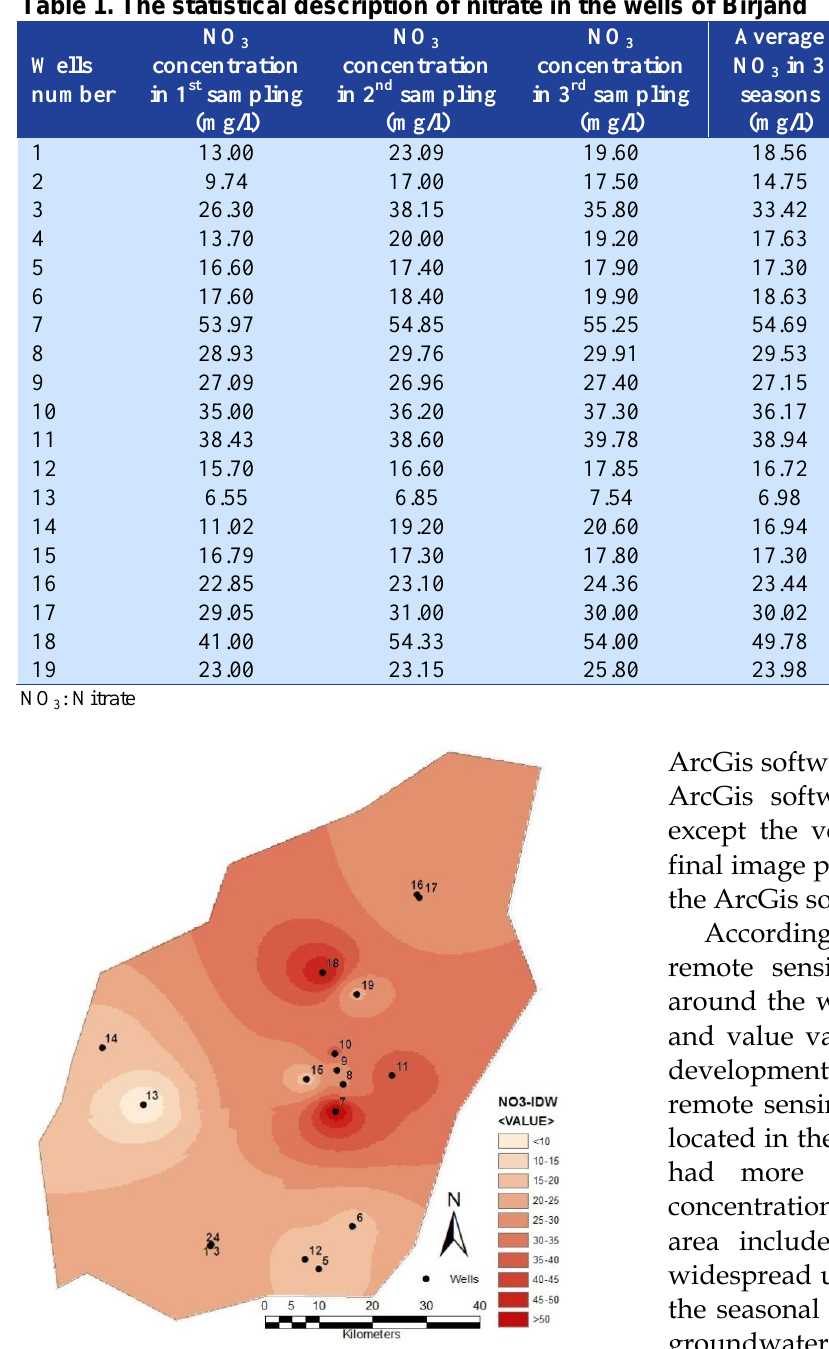
Figure 2. Zoning Nitrate concentration in Birjand wells using inverse distance weighting (IDW) methods In this figure, the vegetation area is displayed in red. For further diagnosis of vegetation area, we used unsupervised classification capacity of ENVI software; then, the extracted image was transferred to